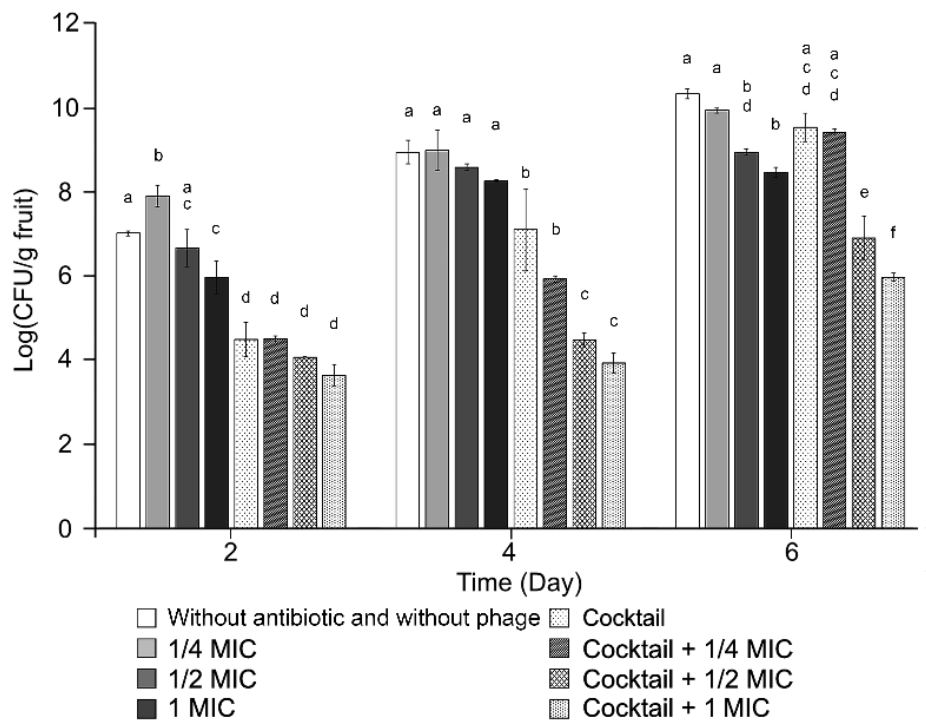
Figure 5. Apple fruit administration of the five-phage cocktail in combination with 0, 1/4, 1/2, or 1 MIC kasugamycin, under controlled conditions. The infective concentration of Erwinia amylovora TS3128 was 2 × 10 5 Colony Forming Unit [CFU]/mL. Viable bacterial cell counts were observed over time. The bars of each point indicate the standard deviation. Statistical significance was calculated using the one-way analysis of variance test with Tukey post-hoc, and the significance threshold was set at p < 0.05. Means at the same sampling time point with different letters (a–f) are significantly different.